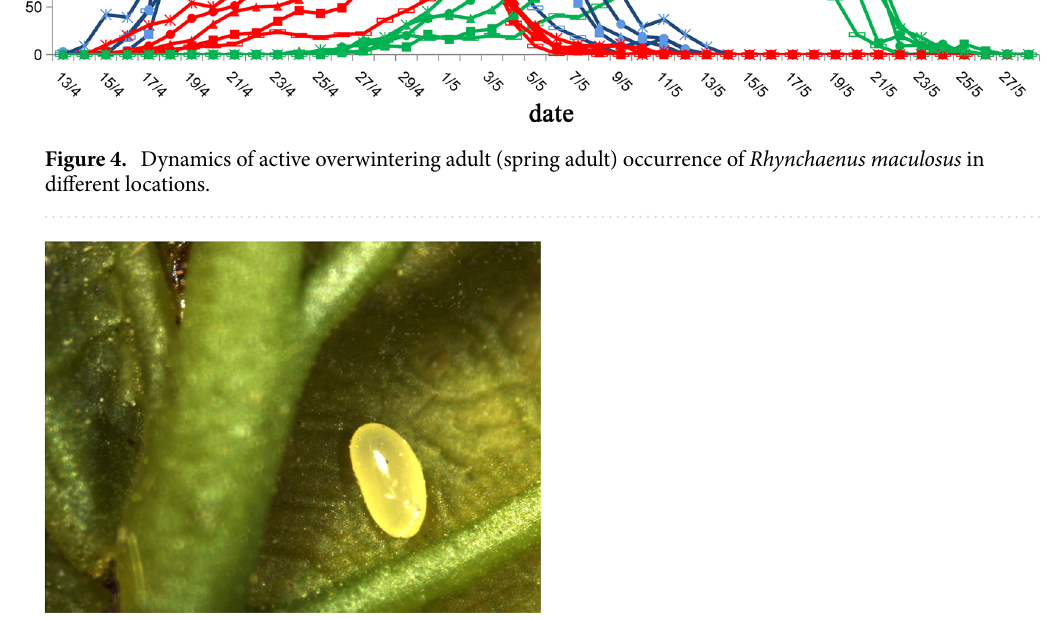
Figure 5. Single egg of Rhynchaenus maculosus deposited near the midvein on the lower surface of the oak